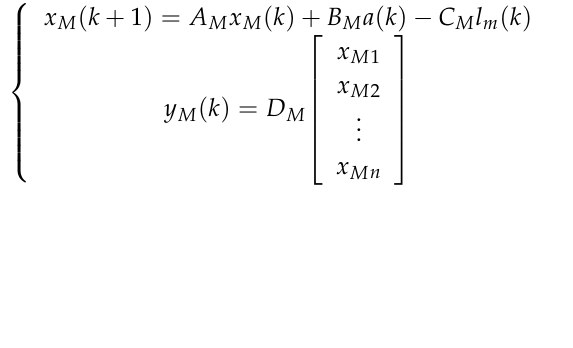
Figure 4. Structure of an n th order 1-bit ∆∑ modulator.